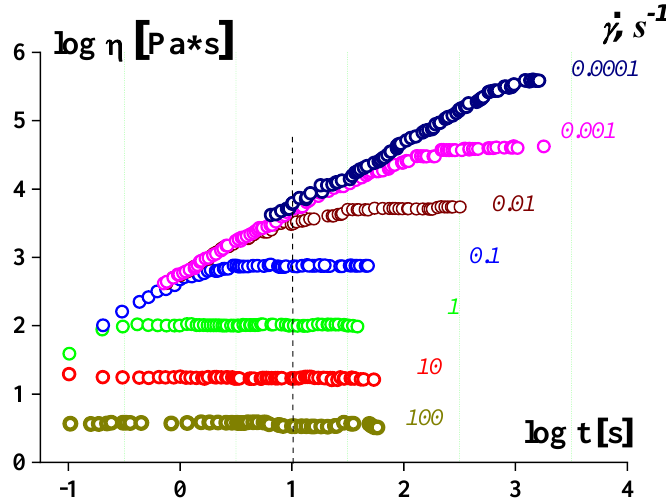
Figure 11. Time effects in measuring a flow curve in the scanning mode. It is seen that the lower the shear rate, the longer the time it takes to reach a time- independent viscosity value. This might be treated as the limit of viscosity corresponding